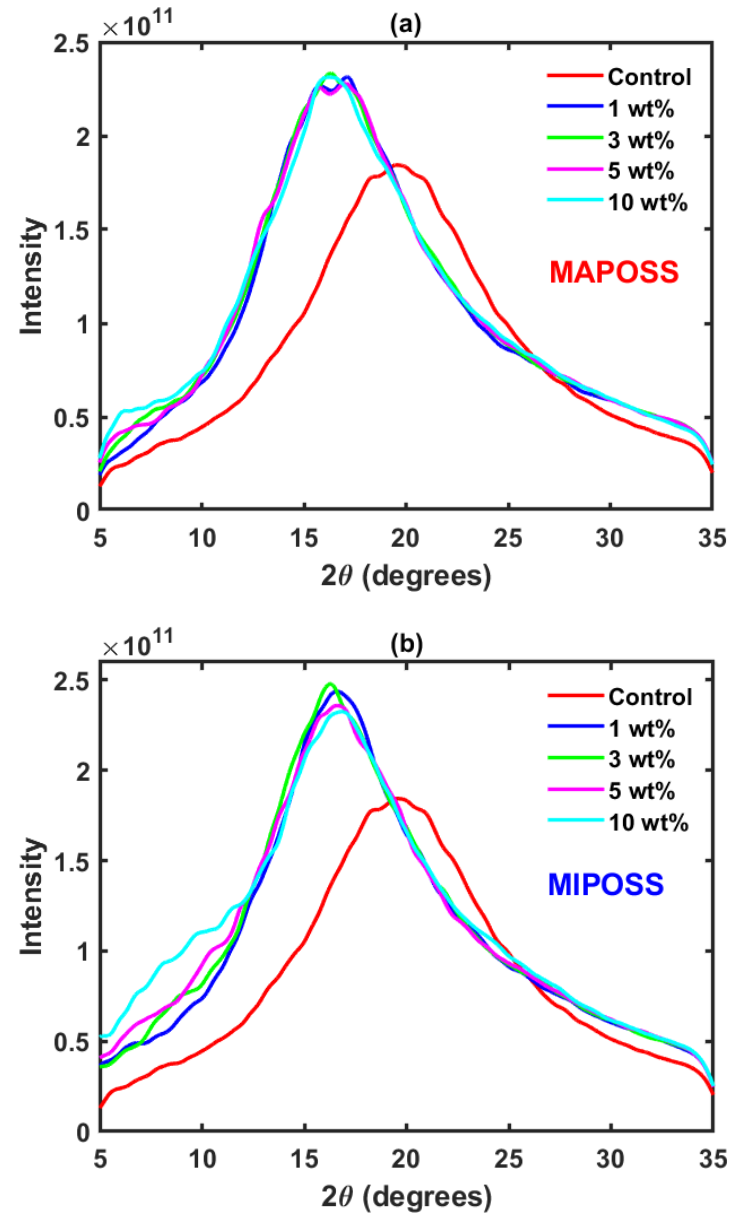
Figure 6. Powder diffraction profiles for ( a ) MAPOSS and ( b ) MIPOSS composites.